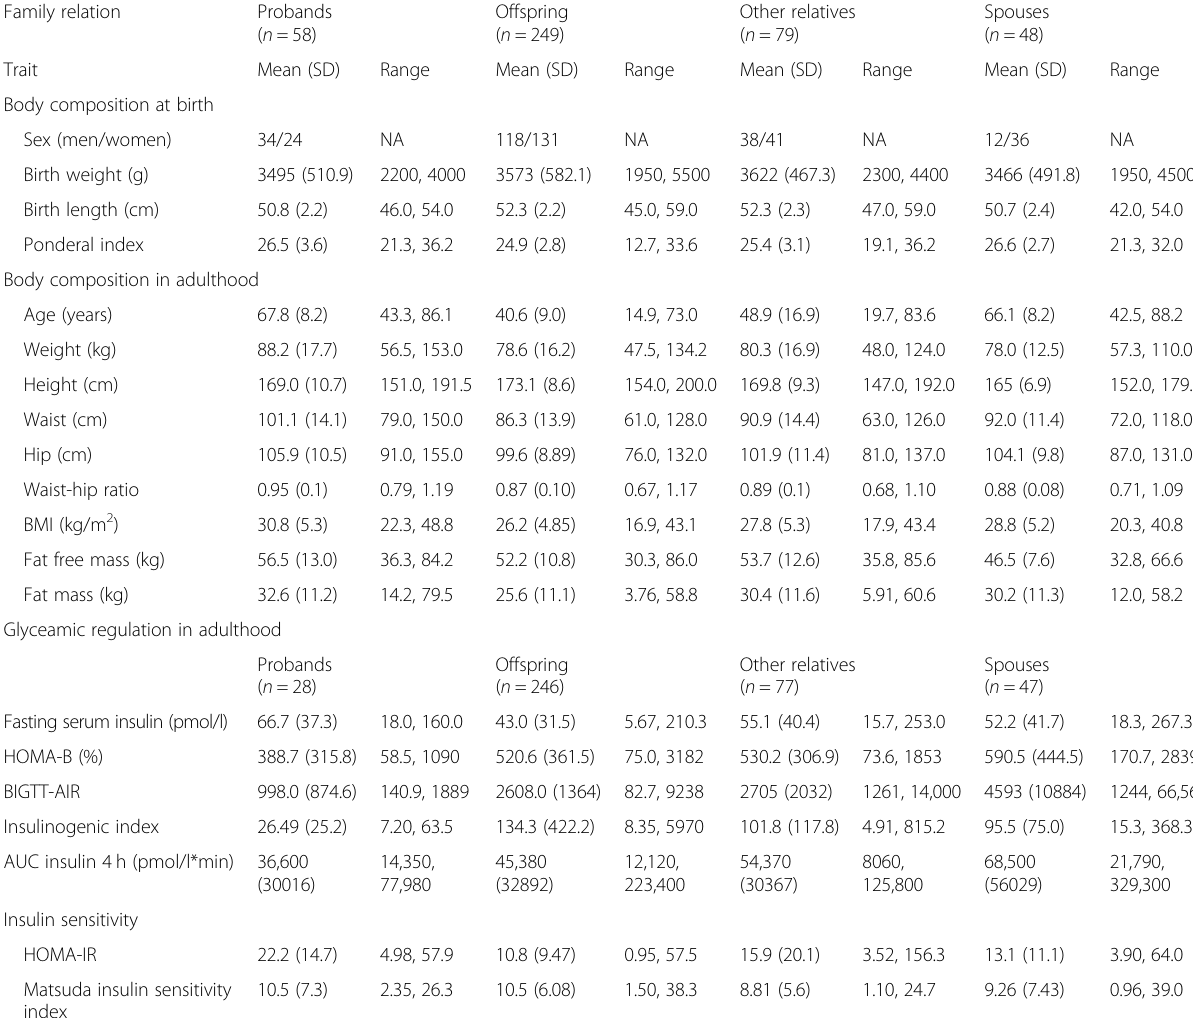
Table 1 Phenotypic characterization of the study population Family relation